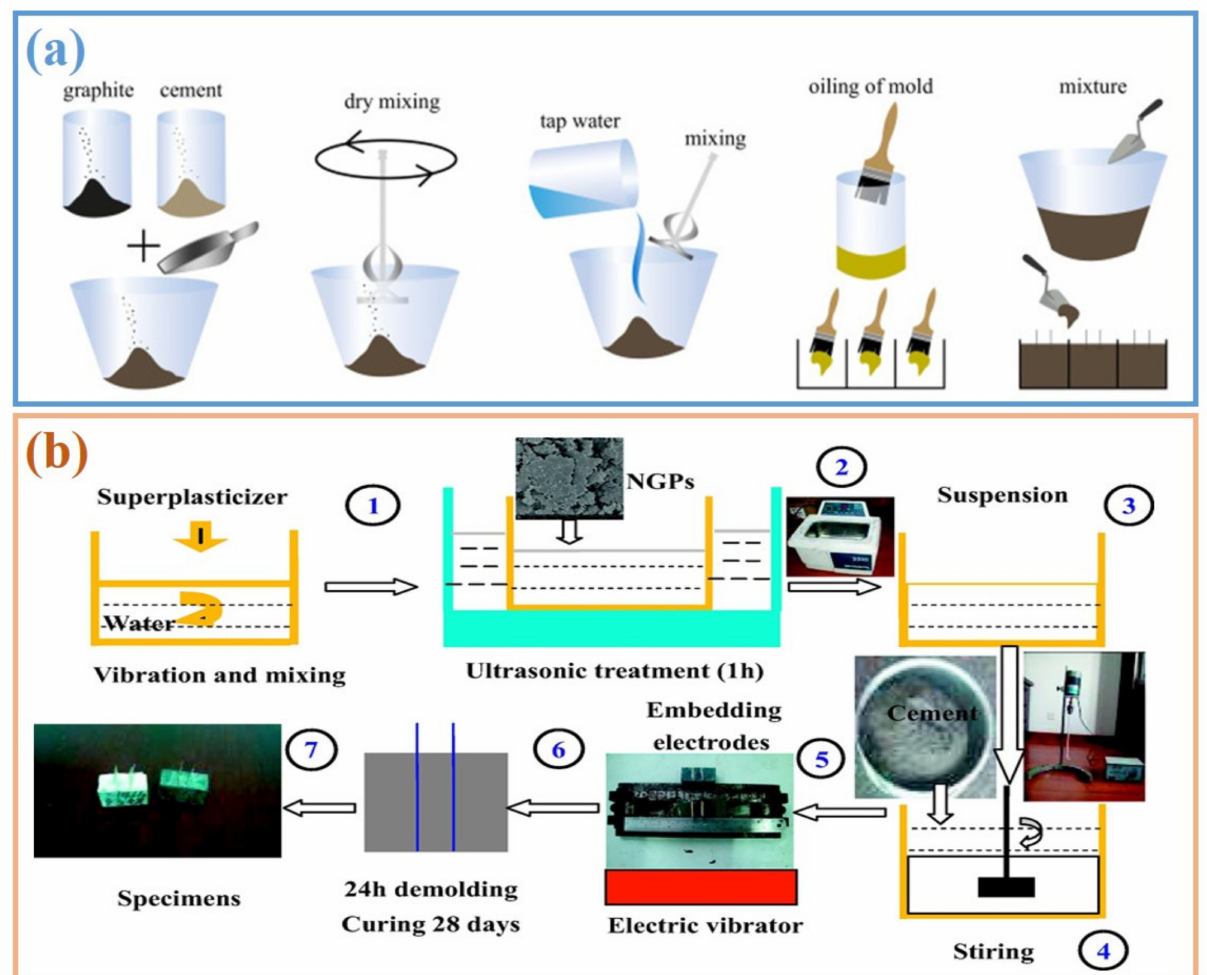
Figure 5. Preparation of graphite filled cementitious composites. Dispersion methods of ( a ) mixing compounds in dry powder form (reprinted (adapted) from [50] which is an open access article and permits unrestricted use); ( b ) adding powders into solution to prepare uniform suspensions (reprinted (adapted) with permission from [51] ©2017 with permission from